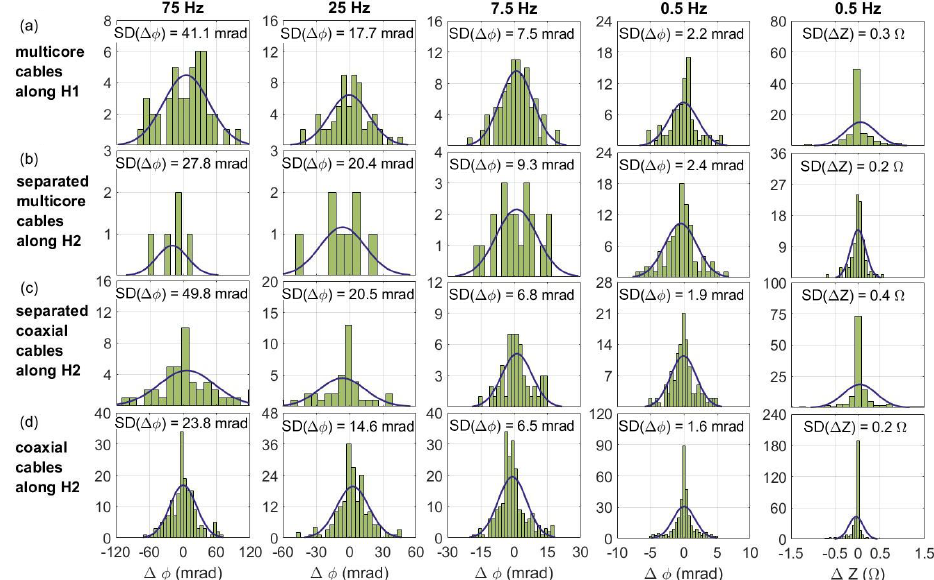
Figure 3. Misfits in phase values between normal and reciprocal phase and resistance readings collected at different frequencies (0.5, 7.5, 25 and 75Hz) and with different cable settings: (a) single multicore cables, (b) separated multicore cables, (c) separated coaxial cables and (d) single coaxial cables. The standard deviation of the N&R misfit (SD ((cid:49)Z) and SD ((cid:49)φ) , respectively) is given in each subplot for each frequency and cable setup representing a quantitative way to compare the different cable setups for all